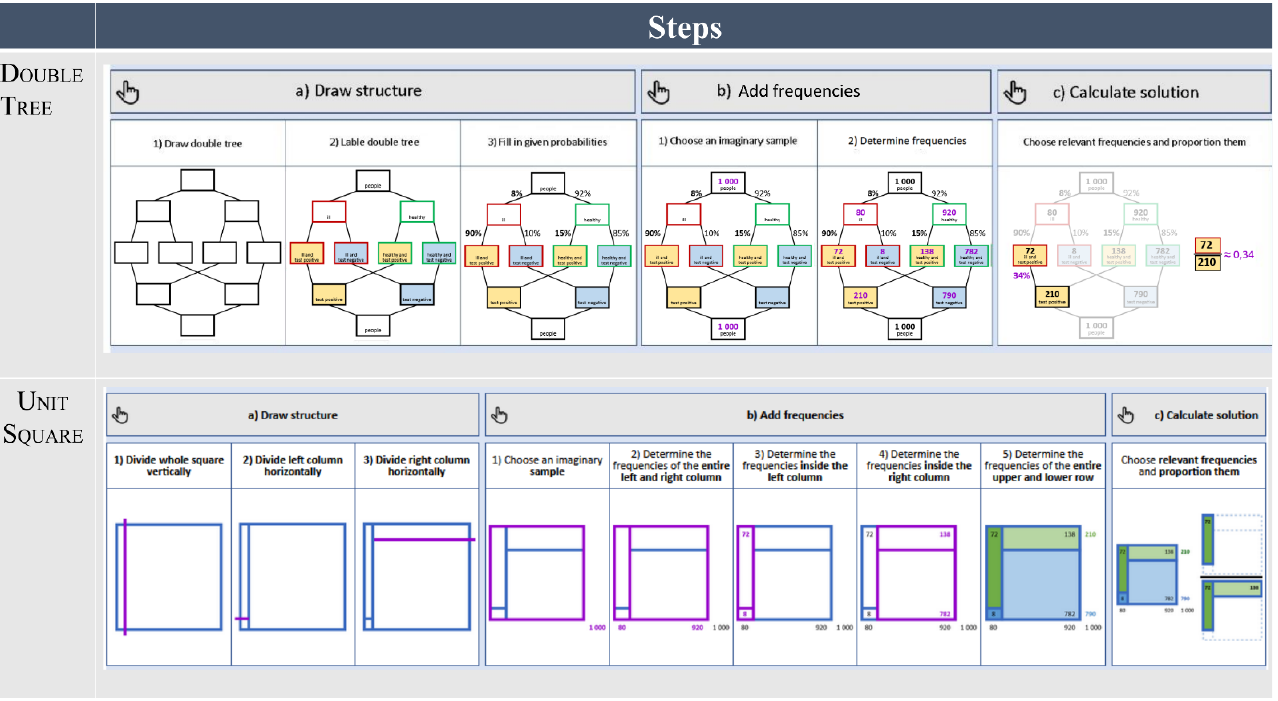
Figure 5. Summaries after each step within the worked example for the double tree and unit square.